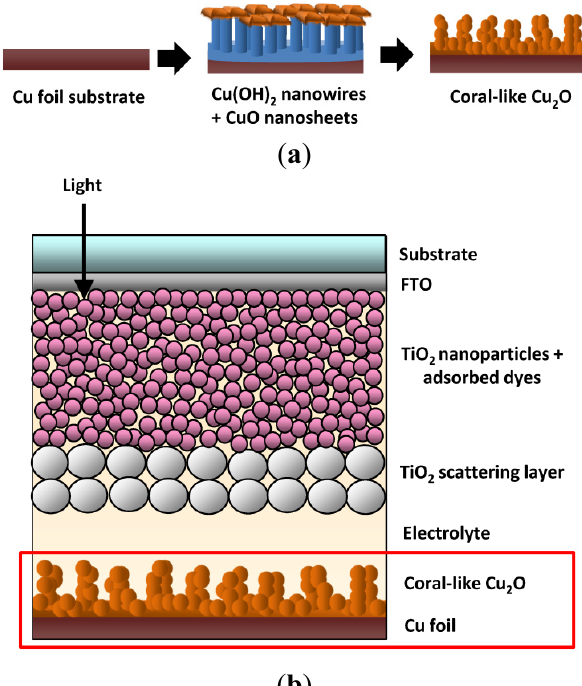
Figure 1. ( a ) The fabrication process of a coral-like Cu 2 O counter electrode, and ( b ) the schematic device structure of a dye-sensitized solar cells (DSSC) using the coral-like Cu 2 O counter electrode.